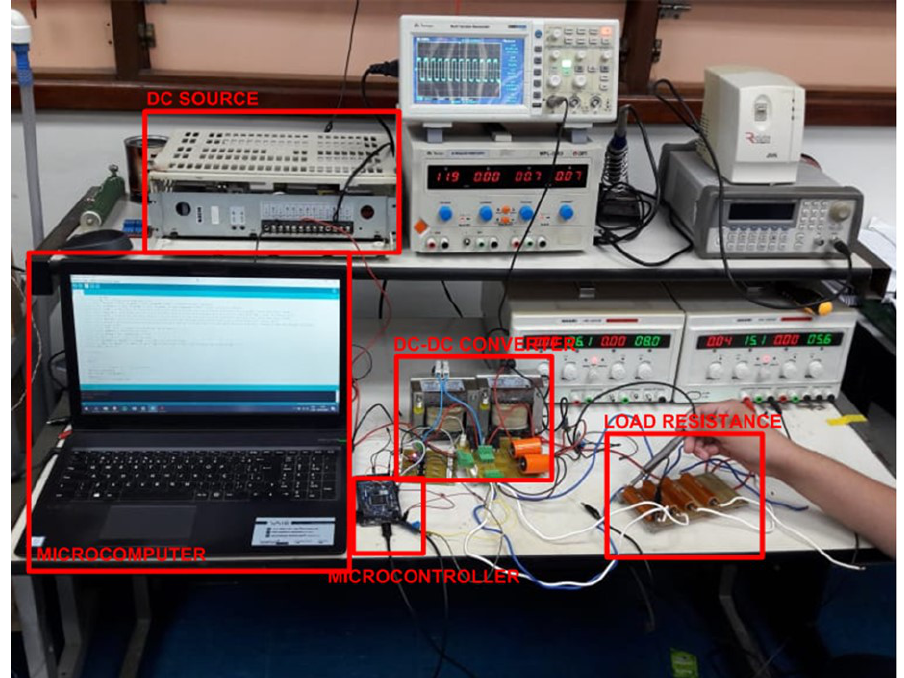
Figure 6. DC-DC Buck converter test board developed and experimental